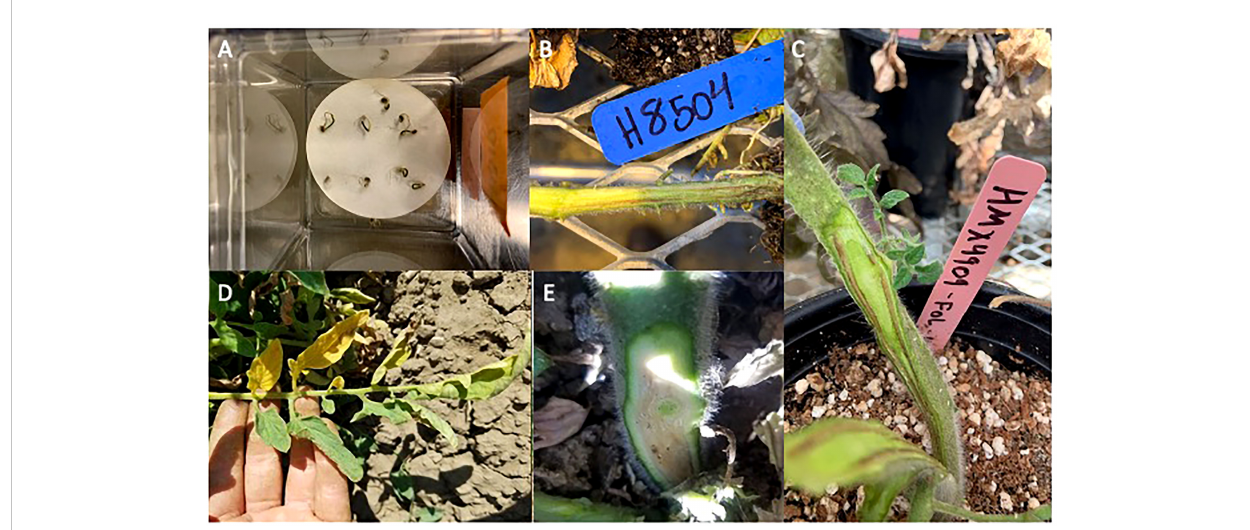
FIGURE 1 Symptom development of tomato at different stages inoculated with Fusarium oxysporum (f) sp. lycopersici race 3 (Fol R3). (A) Seedling decline and H 1310 seedling mortality from the laboratory bioassay. (B) Vascular discoloration of H 8504 developed in a high-throughput assay. (C) Vascular discoloration of HMX 4909 developed in a single-pot assay. (D) One-sided leaf chlorosis observed in a Fol R3 infested fi eld. (E) Vascular discoloration observed in an F3 cultivar under Fol R3 pressure in the fi eld